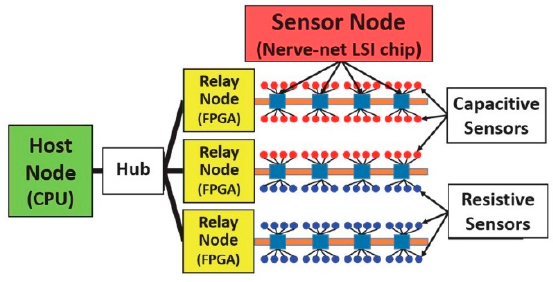
Figure 2. Nerve-net sensing